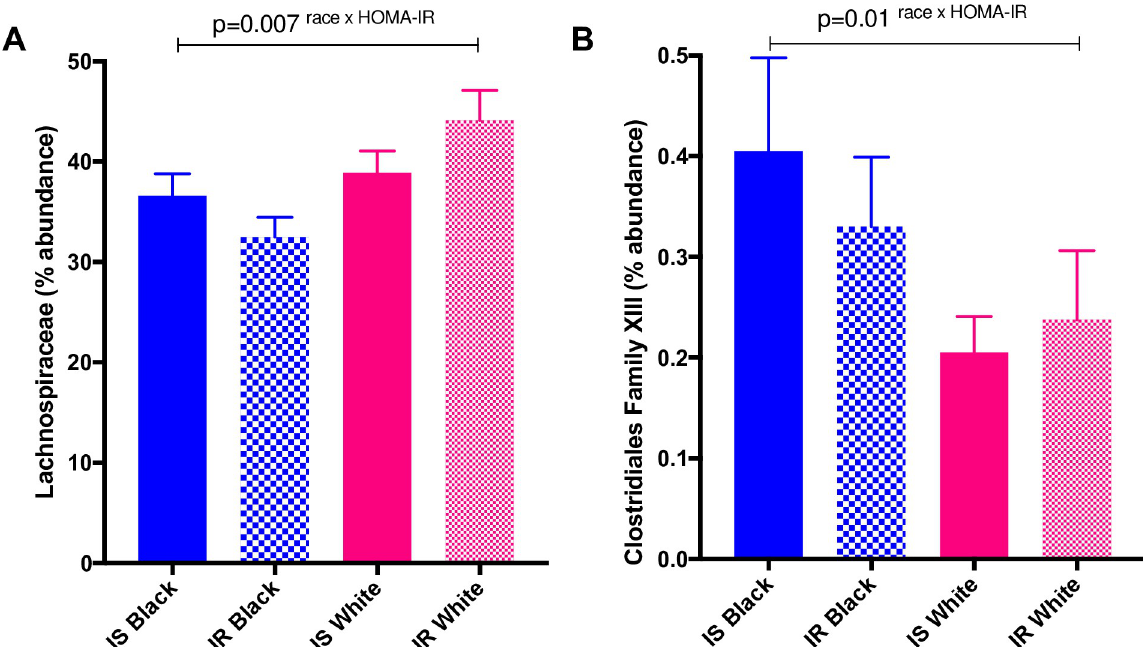
Fig 4. Relative abundance of A) Lachnospiraceae and B) Clostridales Family XIII in fecal samples by race and insulin sensitivity status. Statistical significance determined by a general linear model testing for race x HOMA-IR interaction; significance p < 0.05. Relative abundance was measured by 16S rRNA gene PCR and sequencing.